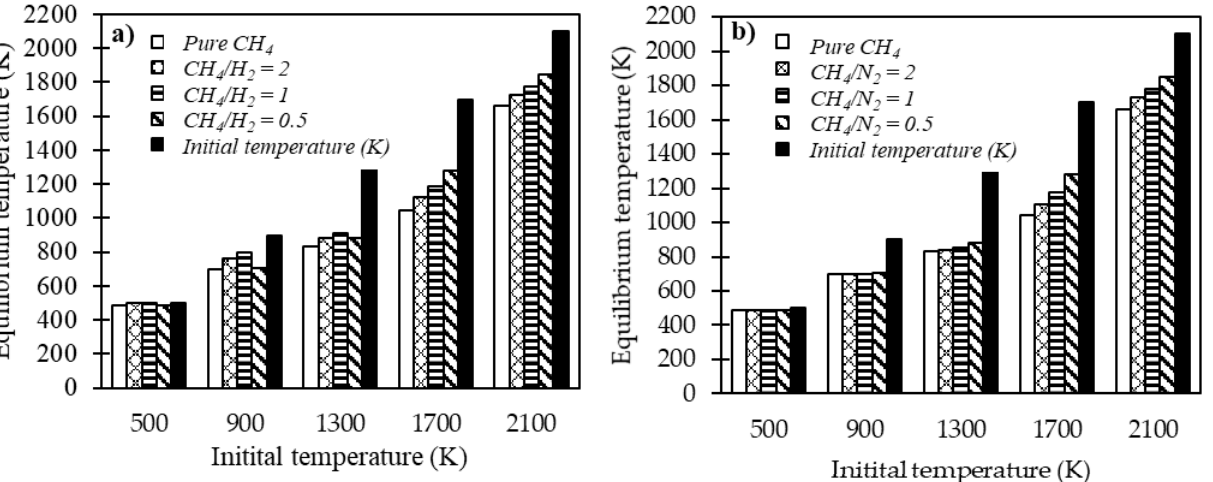
Figure 10. Effect of the addition of hydrogen and nitrogen on the thermal behavior of the methane cracking process at 1 atm (( a ): addition of hydrogen, ( b ): addition of nitrogen).